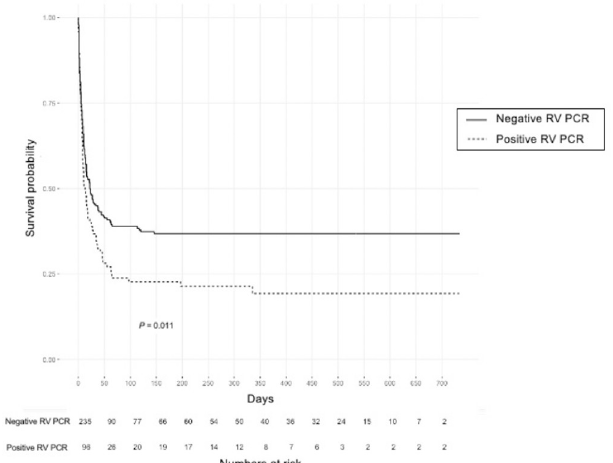
Fig 2. Kaplan-Meier curves of the probability of survival in patients with upper airway respiratory virus (positive RV PCR group, dotted line) and those without (negative RV PCR group, solid line). RV, respiratory virus.